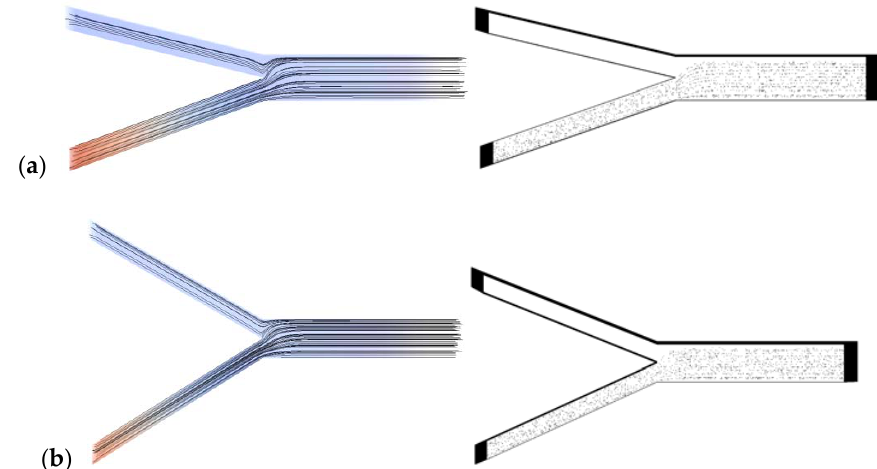
Figure 3. Projection of particles that are located in the last part of the duct with length (cid:1876) (cid:3410) (cid:3013) outlet for θ = 30° and ( a ) Vc = 0.0002, Vp = 0.0001, ( b ) Vc = 0.0001, Vp = 0.0001, and ( c ) Vc = 0.0001, Vp =